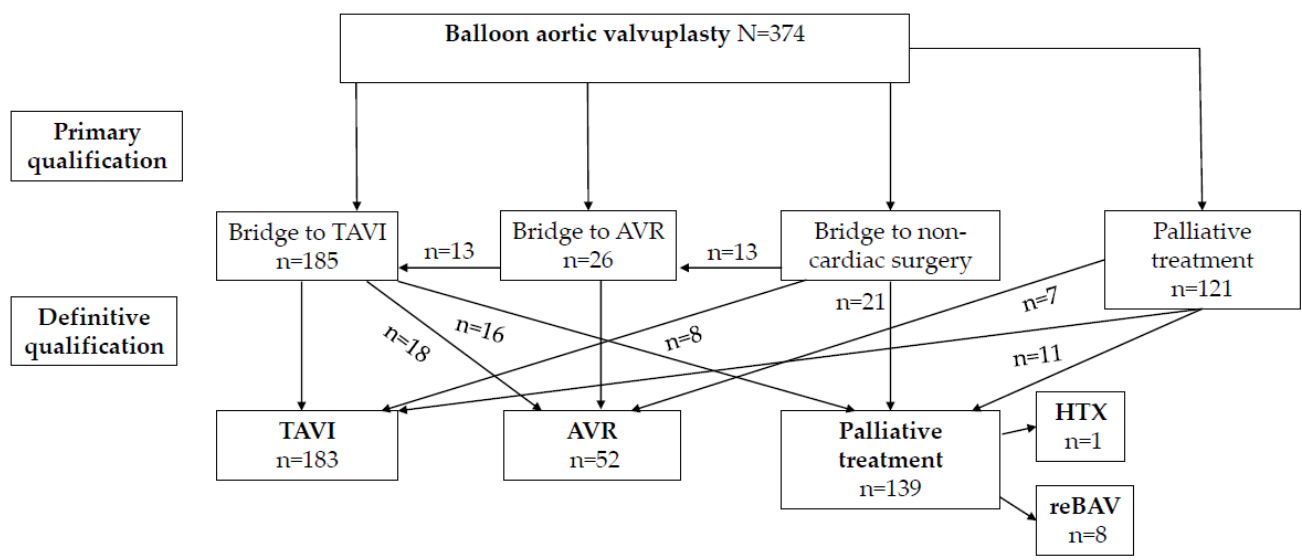
Figure 1. Flowchart of patients undergoing balloon aortic valvuloplasty as a bridge or final therapy. AVR—aortic valve replacement; BAV—balloon aortic valvuloplasty; HTX—heart transplantation; TAVI—transcatheter aortic valve implan- tation.